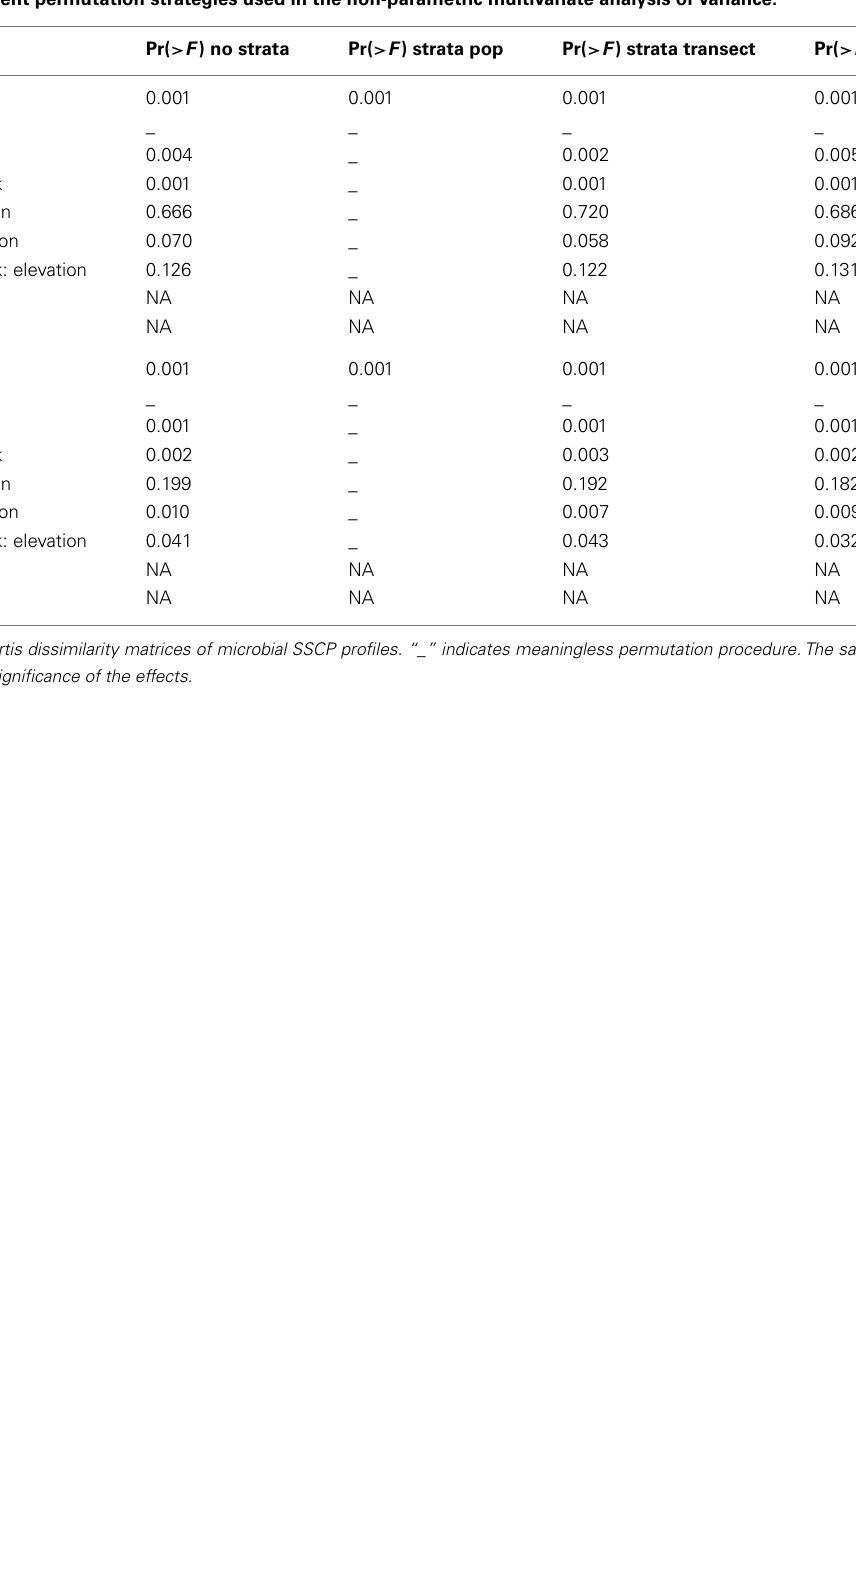
TableA3 | Results of the different permutation strategies used in the non-parametric multivariate analysis of